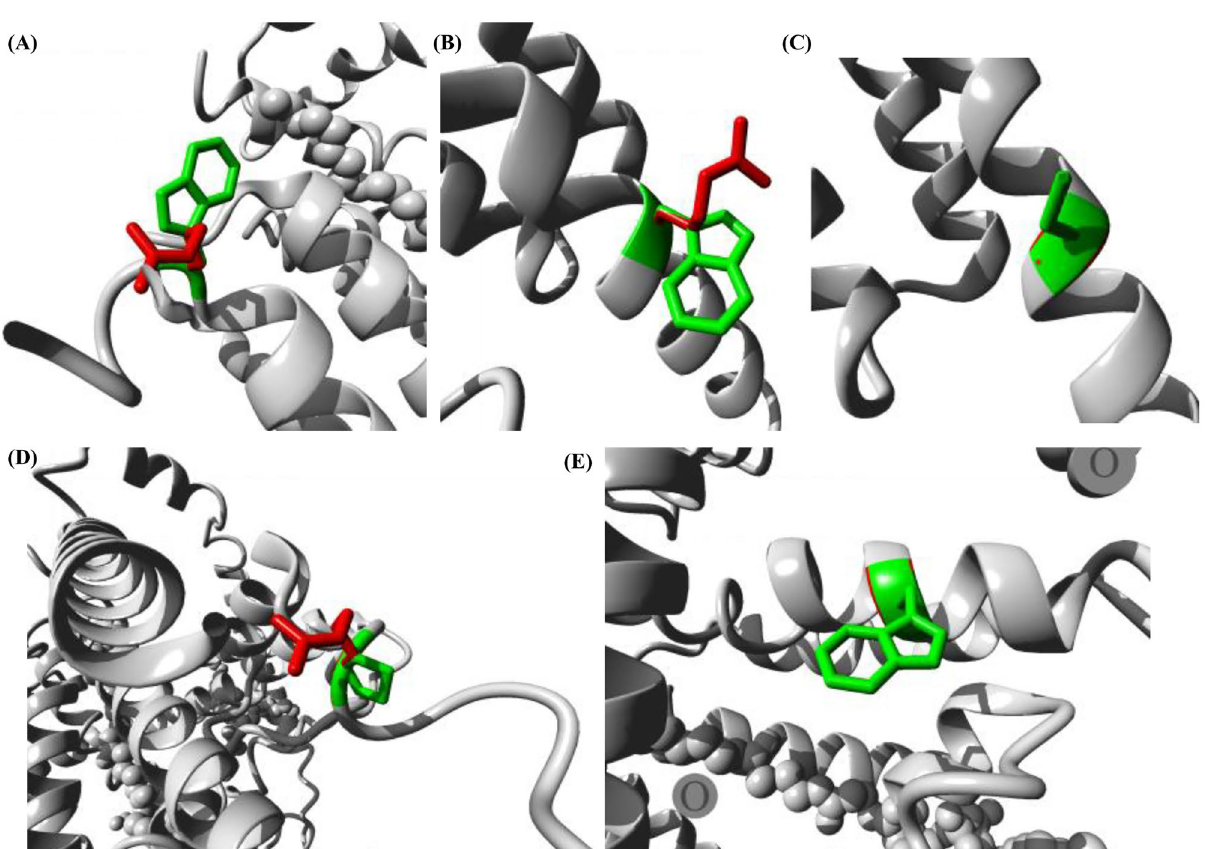
Figure 3. Close-up view of wild type (green) and variant (red) amino acid residues of selected deleterious nsSNPs visualized using the HOPE server. ( A ) W128R, ( B ) W214R, ( C ) C215G, ( D ) P245R, and ( E )